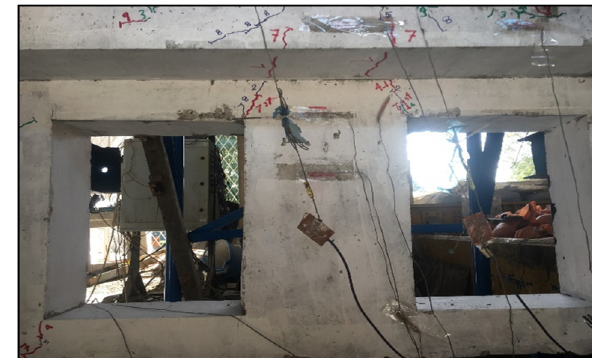
Figure 12: Cracks pattern around openings due to impact